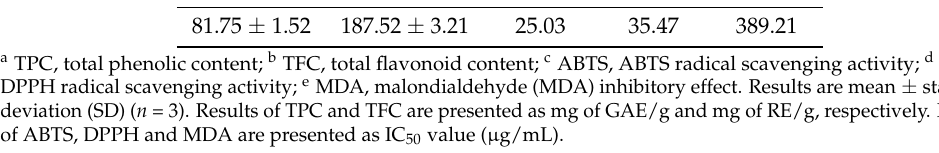
Table 1. Antioxidant capacity of ethyl acetate fraction from persimmon (EFDK). TPC a TFC b ABTS c